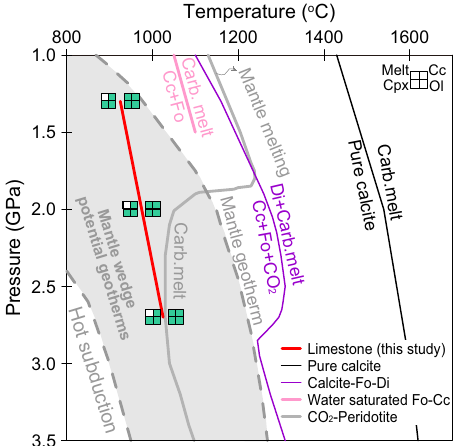
Fig. 3 The solidus curve of limestone in contact with dunite. The limestone solidus curve (red line: phases are shown in squares, Ol olivine, Cpx clinopyroxene, Cc calcite, and melt-carbonatite melt [top-left square]). Melting curves for pure calcite (black line 20 ), the calcite – olivine – clinopyroxene system (purple line 21,22 ), water-rich calcite – olivine system (pink line 23 ), and peridotite + CO 29 ), are shown for comparison. The solidus of limestone in 2 (grey line contact with dunite is about 250°C lower than that of the calcite – olivine – clinopyroxene system and lies between the subduction zone 43 and mantle geotherms (represented by the SE Australia geotherm 66 ). The grey region represents the potential geotherms of the mantle wedge, which is between hot subduction slab surface geotherms and normal